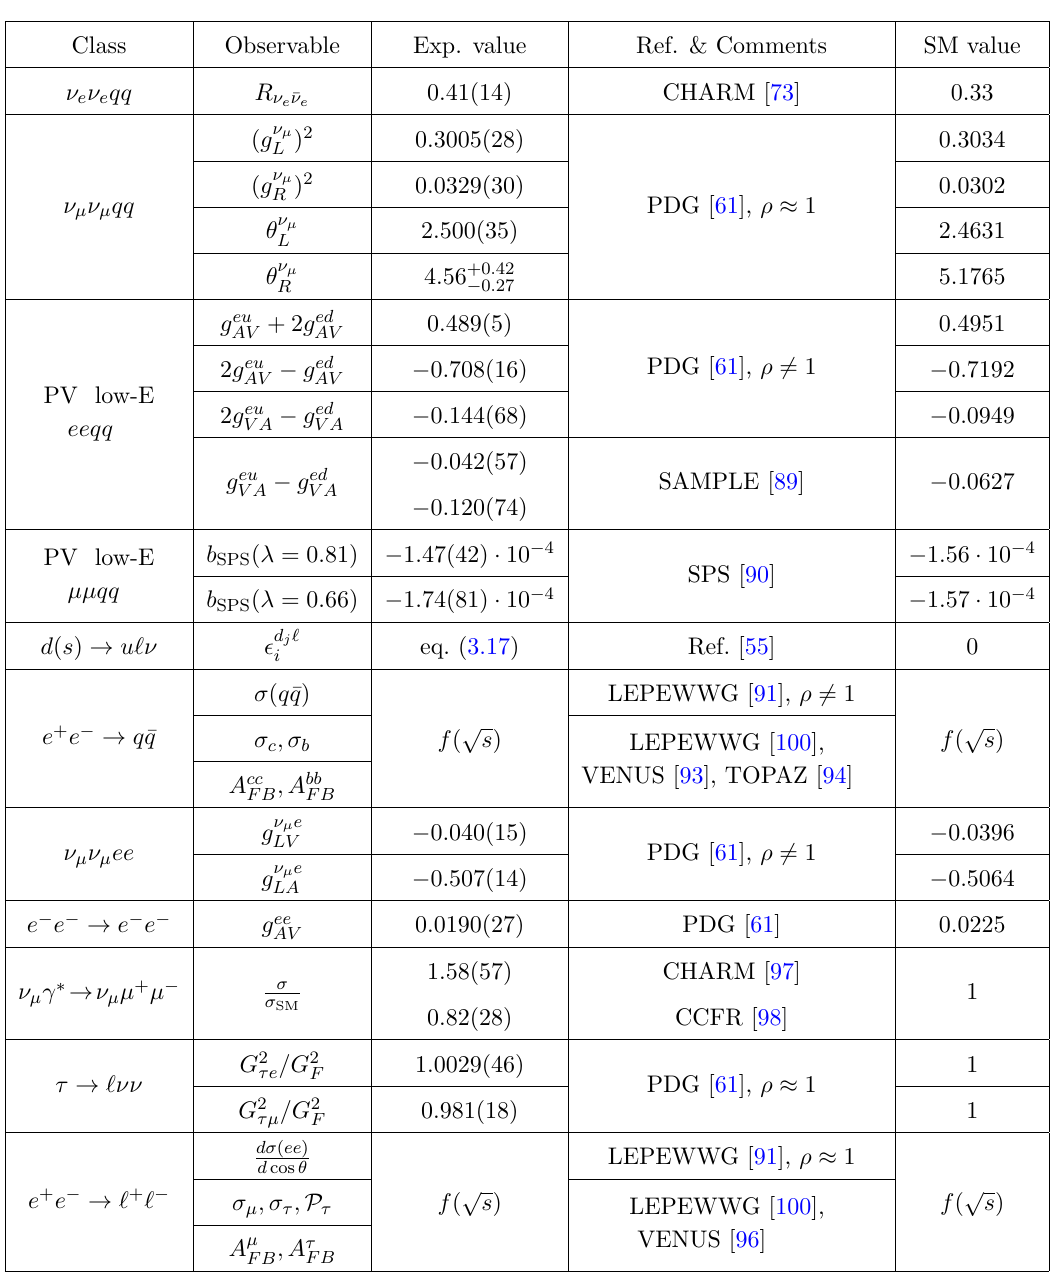
Table 4 . Summary of experimental input (sensitive to LLQQ and LLLL contact interactions) used in our (cid:12)t. The correlations that are taken into account in our (cid:12)t are speci(cid:12)ed. Each observable in e + e (cid:0) ! f (cid:22) f is measured at various c.o.m. energies, which we denote in the table by f ( The speci(cid:12)c numerical values can be found in the corresponding original references. We also use the set of pole observables described in ref. [32] in order to independently constrain the vertex corrections (cid:14)g